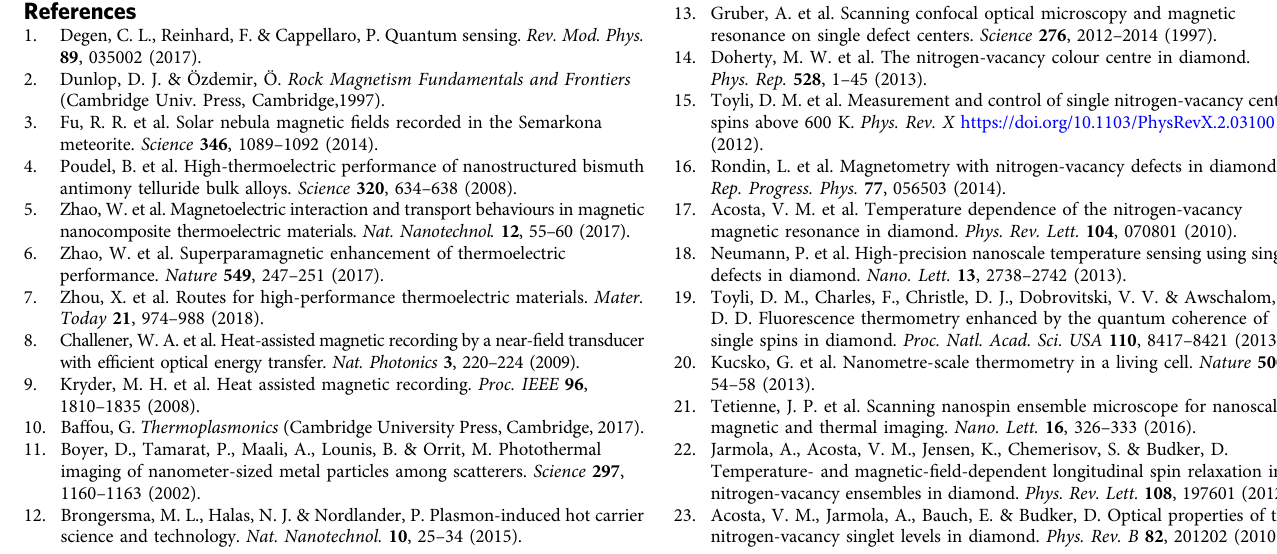
Fig. 6 Temperature calibration by extrapolation of exponential cooling. a Optically detected magnetic resonance (ODMR) spectra for various waiting times t w between the NIR laser pulse and the microwave pulse (indicated by different symbols), 0.3, 0.6, 1.0, 1.4, 2.2} μ s for the others. The pulse sequence in Supplementary Fig. 7 is used. No external magnetic fi eld is applied. The NIR laser power is increased from bottom to top, which is tuned by an optical attenuator (OD0 means full power). The ODMR spectra are fi tted with a Lorentzian dip to extract the zero- fi eld splitting (ZFS) D . b The temperature of the nanodiamond (ND) (relative to the environment temperature T E ) as a function of the waiting duration t w for various NIR laser powers. The temperature lower than 700 K (solid symbols) is obtained using the D - T relation in ref. 15 . All the data for t w > 0 are well fi tted with an exponential decay function. By extrapolation, the temperature immediately after the heating pulse is obtained (red open circles). The plateau before the end of the heating pulse (marked by the vertical dotted line) is due to the AOM delay ( ≈ 200 ns). Error bars corresponding to the standard fi tting